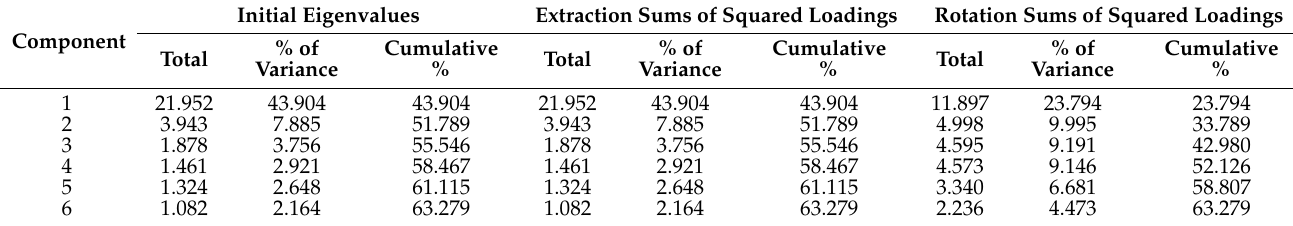
Table 4. Principal component analysis results for